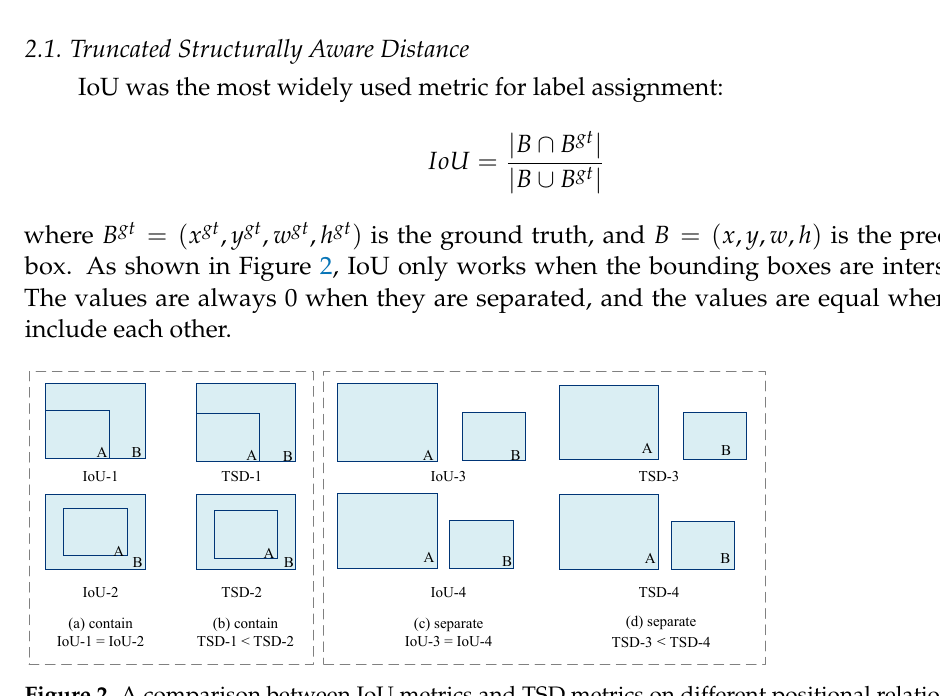
Figure 2. A comparison between IoU metrics and TSD metrics on different positional relationships. ( a , b ) represent the containment relationship, and ( c , d ) represent the separation